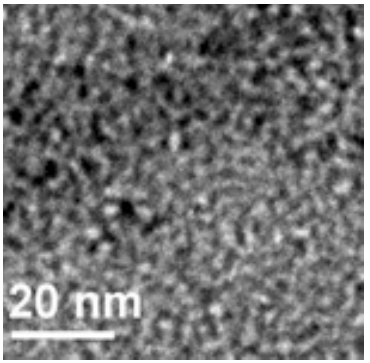
Fig. 2. TEM image of ZAIS QDs.